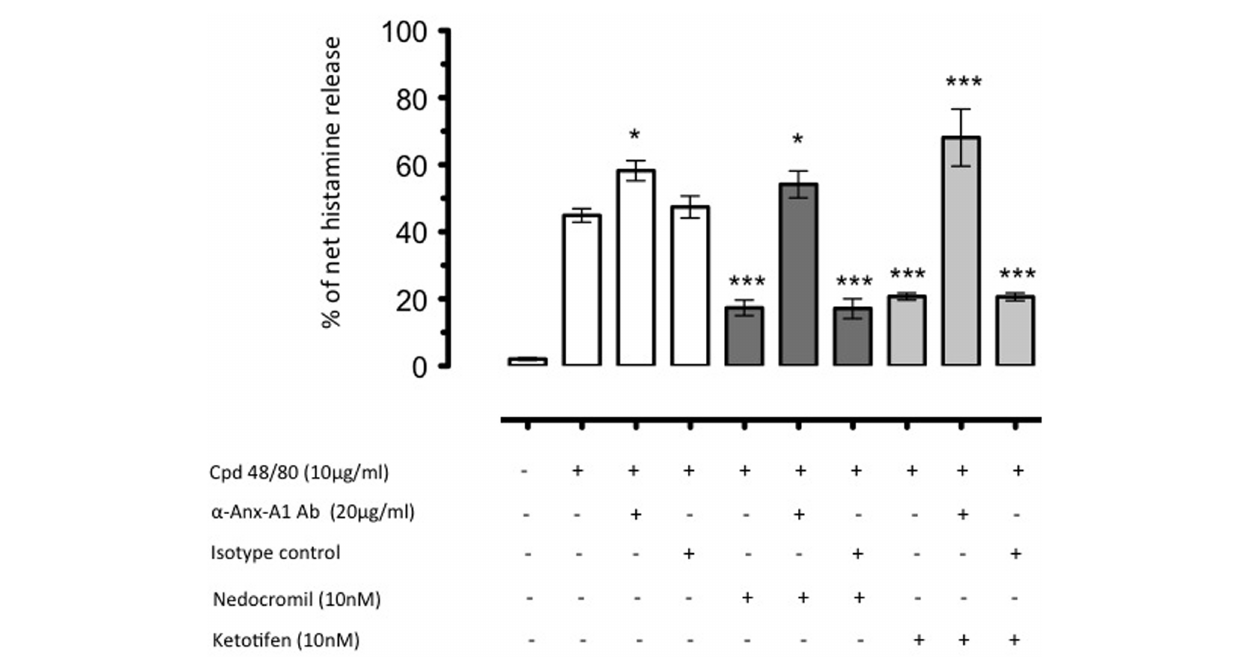
FIGURE 2 | The inhibition by nedocromil and ketotifen of mediator release from Cord blood derived mast cells (CBDMCs) stimulated with compound 48/80 is dependent upon Anx-A1. CBDMCs were plated at a density of 2 × 10 5 cells per well and the stipulated groups were treated with 20 µ g/ml Anx-A1 neutralizing antibody or an irrelevant isotype control. Subsequently, the cells were pre-treated with either nedocromil (10 nM) or ketotifen (10 nM) for 5 min followed by compound 48/80 (10 µ g/ml) stimulation for 10 min. To assess the effects of Anx-A1 removal, the cells were incubated with the Anx-A1 neutralizing antibody (or an irrelevant isotype control) only. Nedocromil and ketotifen produced consistent inhibition of histamine, but not control isotype matched non-neutralizing mAb. Data are expressed as mean ± SEM from n = 3 experiment and were analysed using one-way analysis of variance (ANOVA), followed by a Bonferroni post hoc test, ∗ p < 0.05, ∗∗∗ p < 0.001 vs unstimulated). Figure reproduced with the permission from the rights holder, Elsevier (Sinniah et al.,